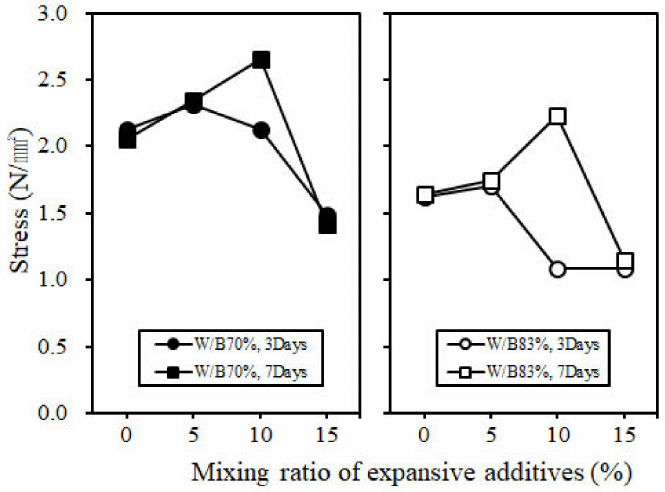
Figure 3. Frictional resistance